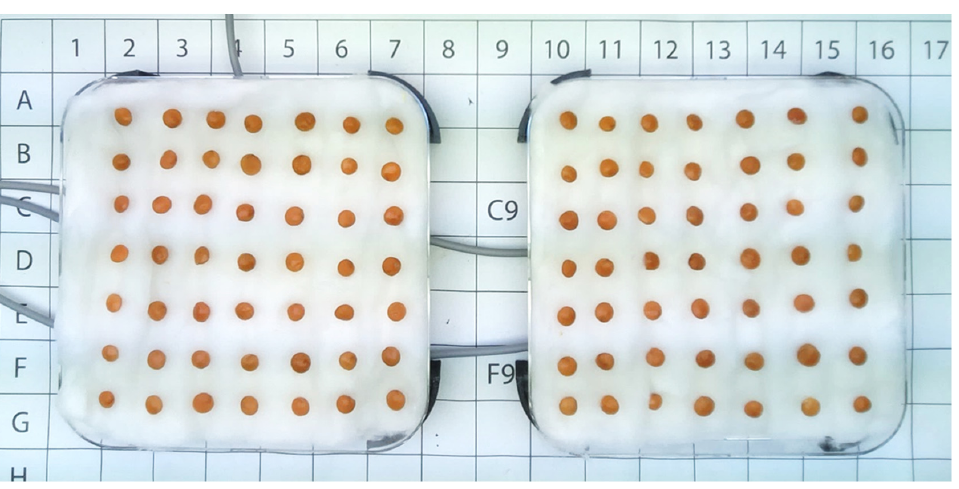
Figure 2. Arrangement of red lentil seeds on cotton. The same operations described above were repeated both for the samples treated with mechanical waves and for the control samples. The two plates with the lentil samples were placed inside a growth chamber with controlled temperature and brightness. The temperature reached values of 22–23 °C. Brightness depended on the position of the two plates (Figure 2): specifically, the left plate was irradiated with 6100 lux, while the right one was radiated with 5750 lux. For this reason, the plates were placed on an orderly grid with letters and numbers to precisely define any location. The photoperiod was set to cy- cles of 16 h of light and 8 h of darkness. The plates rested on a raised plastic support made with a 3D printer (Ultimaker S3, Ultimaker B.V., Utrecht, Netherlands). This left valuable space to allow the fixation of the magneto dynamic transducers in a central position on the lower portion of the plates, as shown in Figure 3a.